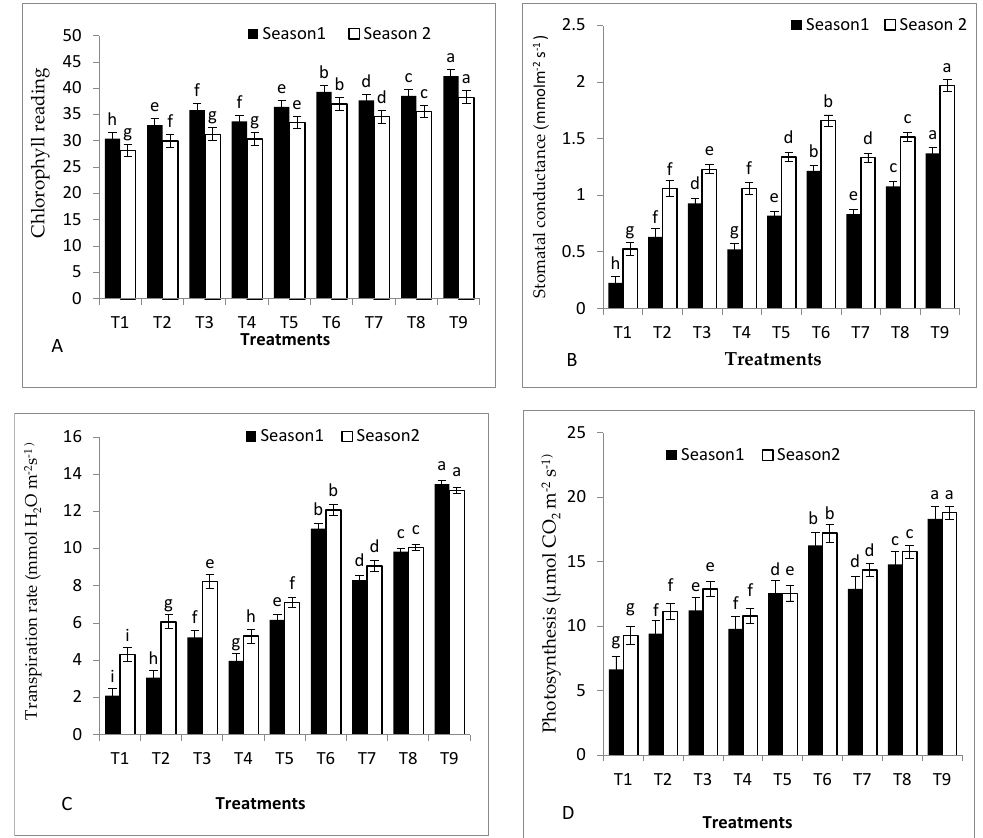
Figure 2. Effects of grafting, rootstock seed treated with SA, and colonisation with S. griseus on ( A ) chlorophyll content (SPAD), ( B ) stomatal conductance, ( C ) transpiration rate, and ( D ) photosynthe- sis, in the first and second seasons. Treatments: T1—self-grafted Peto 86/Peto 86 (control); T2—Peto 86/ S. cheesmaniae ; T3—Peto 86/GS hybrid; T4—Peto 86/Peto 86 + SA; T5—Peto 86/ S. cheesmaniae + SA; T6—Peto 86/GS hybrid + SA; T7—Peto 86/Peto 86 + S. griseus; T8 —Peto 86/ S. cheesmaniae + S. griseus; and T9—Peto 86/GS hybrid + S. griseus. Standard errors of the mean are shown as vertical bars; the LSD test indicates that differences between values in each bar that are marked by different letters are significant at p = 0.05.